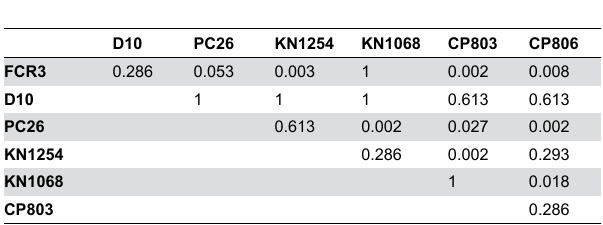
Table 3. Contingency analysis to determine whether IgG responses to parasite strains correlate with each other: pre- transmission season. a